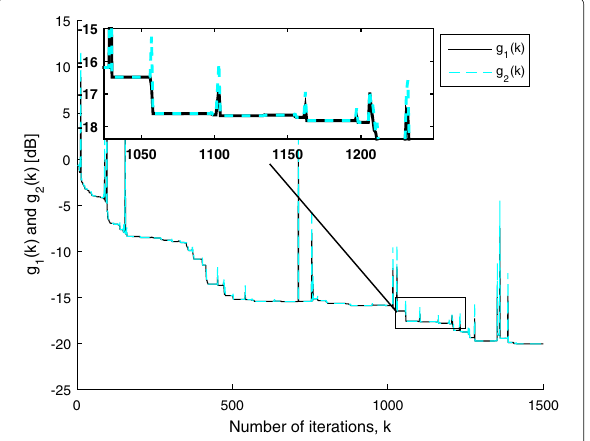
Fig. 2 (cid:3) ˜ w ( k ) (cid:3) 2 (cid:2) (cid:3) w o − w ( k ) (cid:3) 2 for the NLMS and the SM-NLMS